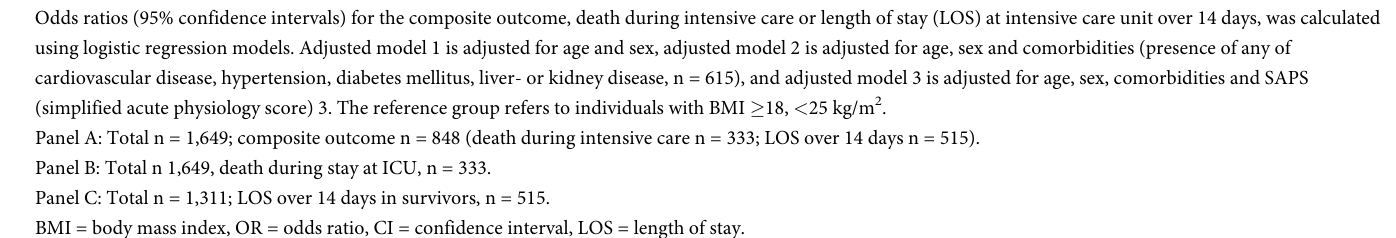
Odds ratios (95% confidence intervals) for the composite outcome, death during intensive care or length of stay (LOS) at intensive care unit over 14 days, was calculated using logistic regression models. Adjusted model 1 is adjusted for age and sex, adjusted model 2 is adjusted for age, sex and comorbidities (presence of any of cardiovascular disease, hypertension, diabetes mellitus, liver- or kidney disease, n = 615), and adjusted model 3 is adjusted for age, sex, comorbidities and SAPS (simplified acute physiology score) 3. The reference group refers to individuals with BMI � 18, < 25 kg/m 2 . Panel A: Total n = 1,649; composite outcome n = 848 (death during intensive care n = 333; LOS over 14 days n = 515). Panel B: Total n 1,649, death during stay at ICU, n = 333. Panel C: Total n = 1,311; LOS over 14 days in survivors, n = 515. BMI = body mass index, OR = odds ratio, CI = confidence interval, LOS = length of